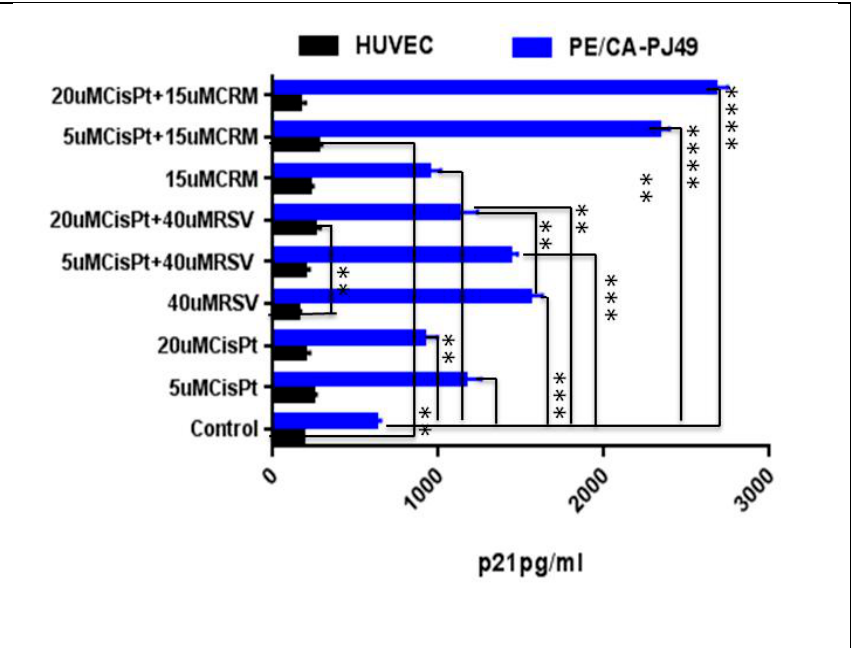
Figure 3. The total p21 protein expression (pg/mL) in normal cell line-HUVEC and in tumor cell line-PE/CA-PJ49 cells treated 24 h with CisPt and/or RSV, CRM. The experiments were performed in triplicates. Results are expressed as mean values of three determinations ± standard deviation (SD). (* p < 0.05, ** p < 0.005; *** p < 0.0005).